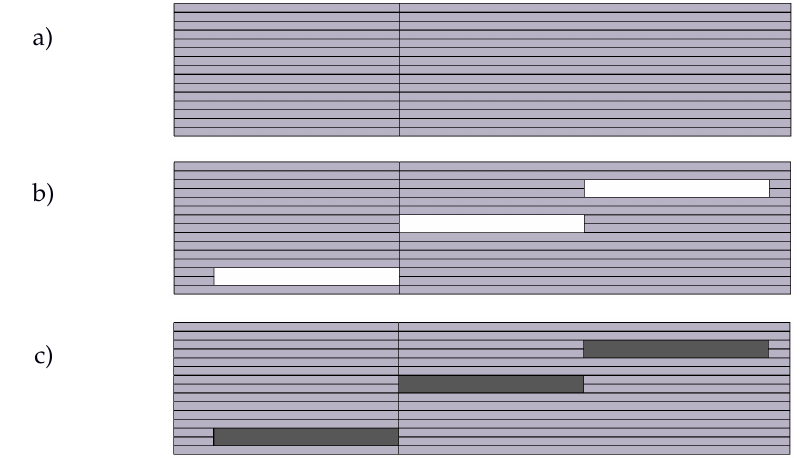
Figure 5. Laminate structure for interlaminar shear strength testing.( a ) Laminate without gaps; ( b ) Laminate with gaps; ( c ) Laminate with printed continuos fiber reinforced thermoplastic